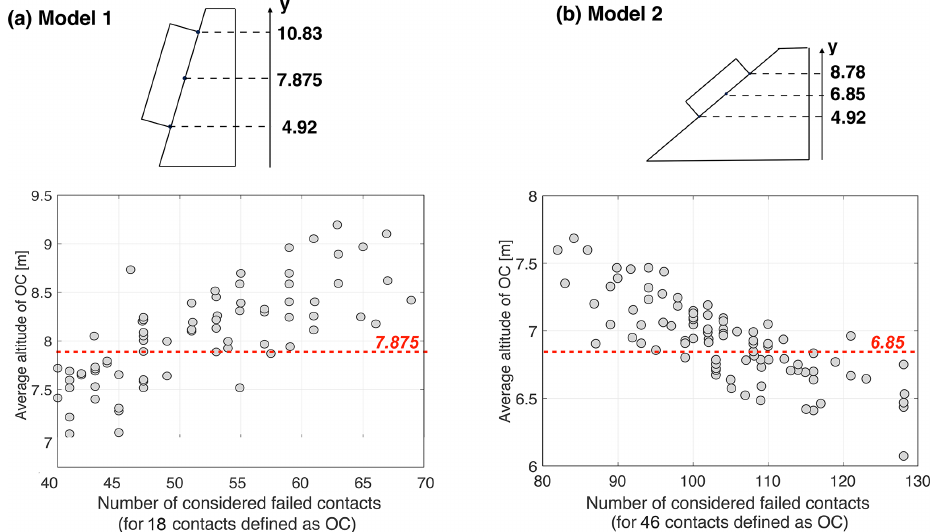
Figure 8. Number of considered failed contacts for a number N of contacts defined to be OC with respect to the average altitude ( y coordinate) of the OC contacts, for models 1 and 2 considering Scenario 3 (run two times). N is equal to 18 and 46 for model 1 and 2